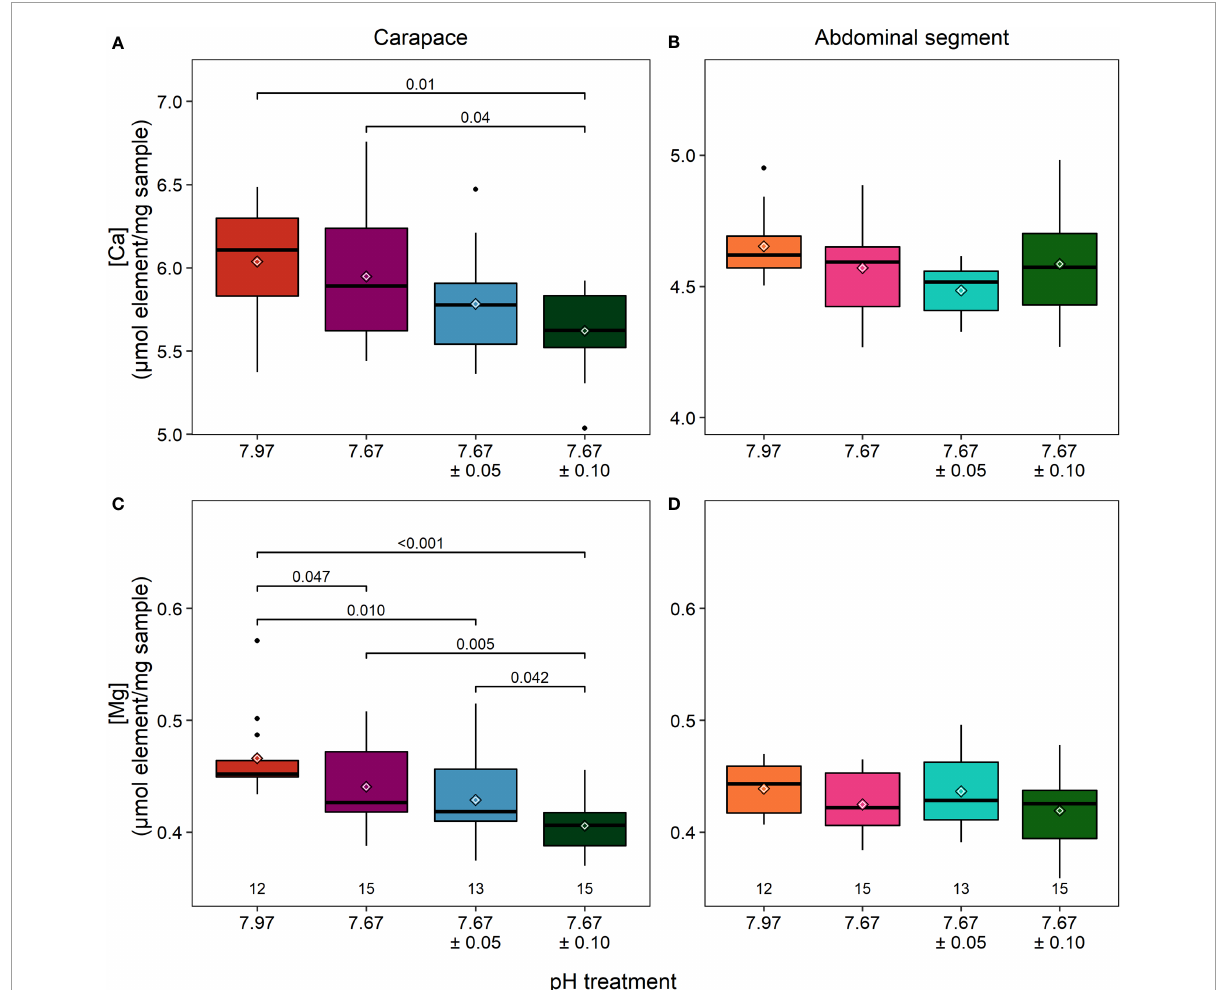
FIGURE 4 Calcium (A, B) and magnesium (C, D) concentrations measured with ICP-MS. In the carapace of lobsters in the reduced/high fluctuating treatment (7.67 ± 0.10), there was significantly less calcium (A) present than in lobsters in ambient/stable conditions. Lobsters in both fluctuating treatments had significantly less magnesium than those in ambient/stable treatments. There were no differences found in the cuticle of the abdominal segment, which had lower and less variable amounts of calcium but similar amounts of Mg to the carapace. Note different axes for panels (A, B) α =0.025 after a Bonferroni correction. Box boundaries are the first and third quartiles, whiskers are 1.5 times the interquartile range, the center line is the median, black and white diamonds are the mean, and outliers are solid dots. Values on the bottom of panels denote sample